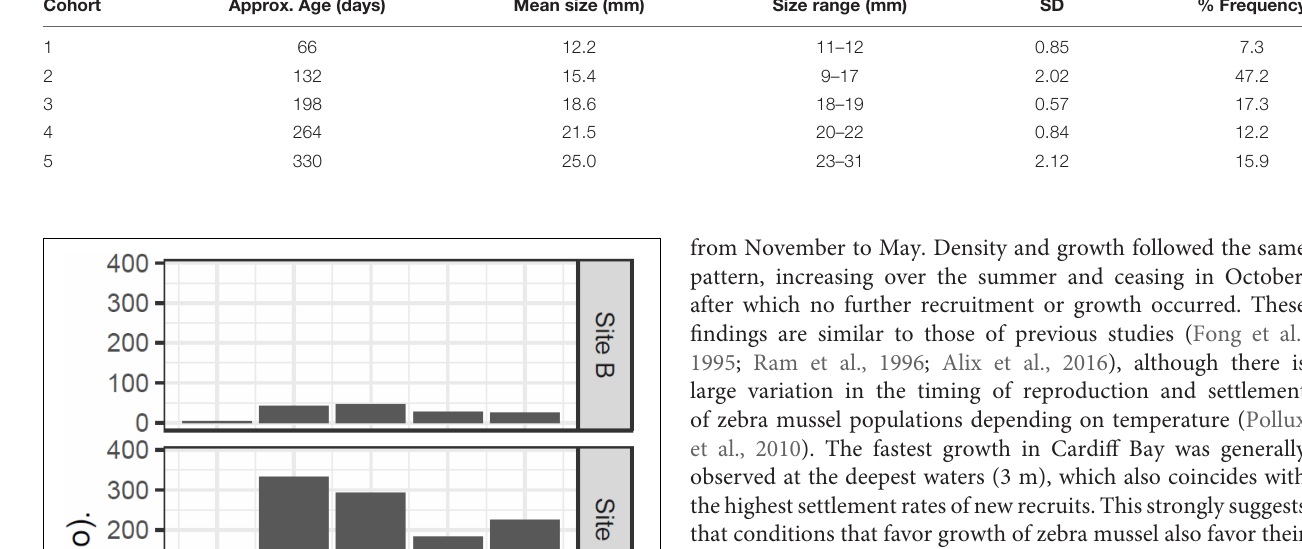
TABLE 3 | Estimated cohort composition of successive waves of zebra mussels colonizing experimental panels in Cardiff Bay over a 12 month period, based on mixture analysis of shell length frequency data ( n = 2,785). Cohort